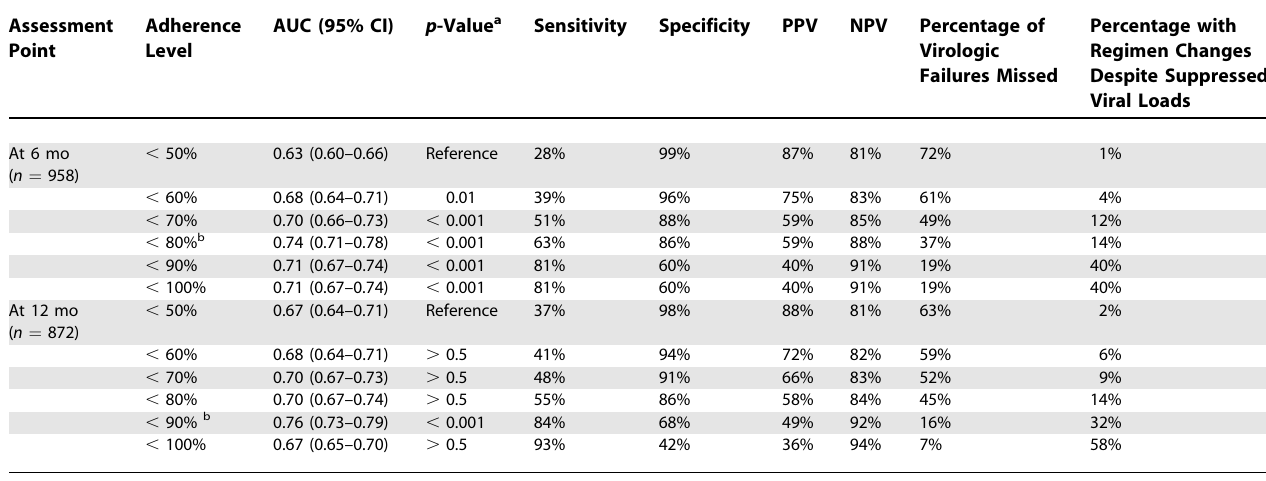
Table 3. Test Characteristics for Adherence Levels for Identifying Patients with Virologic Failure after Initiating cART when Assessed